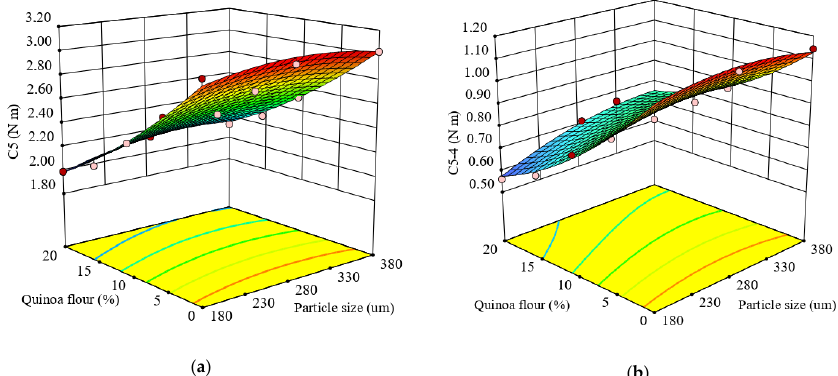
Figure 5. Response surface graph for combined effects of quinoa flour particle size and level added in refined wheat flour on Mixolab parameters during starch retrogradation: ( a ) C5 torque (C5) and ( b ) difference between torques C5 and C4 (C5–4 ).